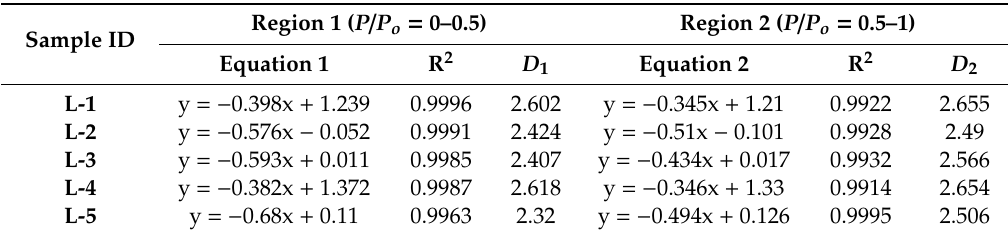
Table 3. Fractal dimensions obtained from Frenkel–Halsey–Hill (FHH)